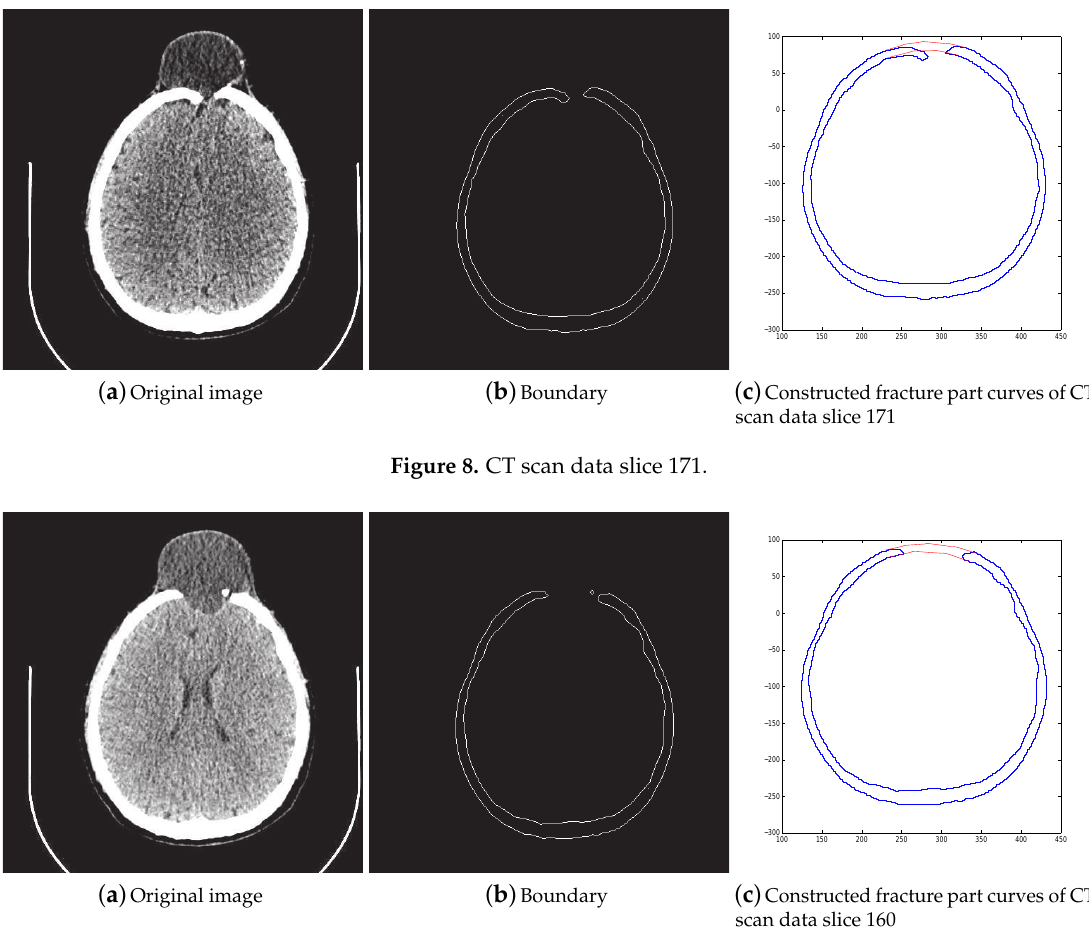
Figure 7. Reconstructed image of CT scan data slice 176.